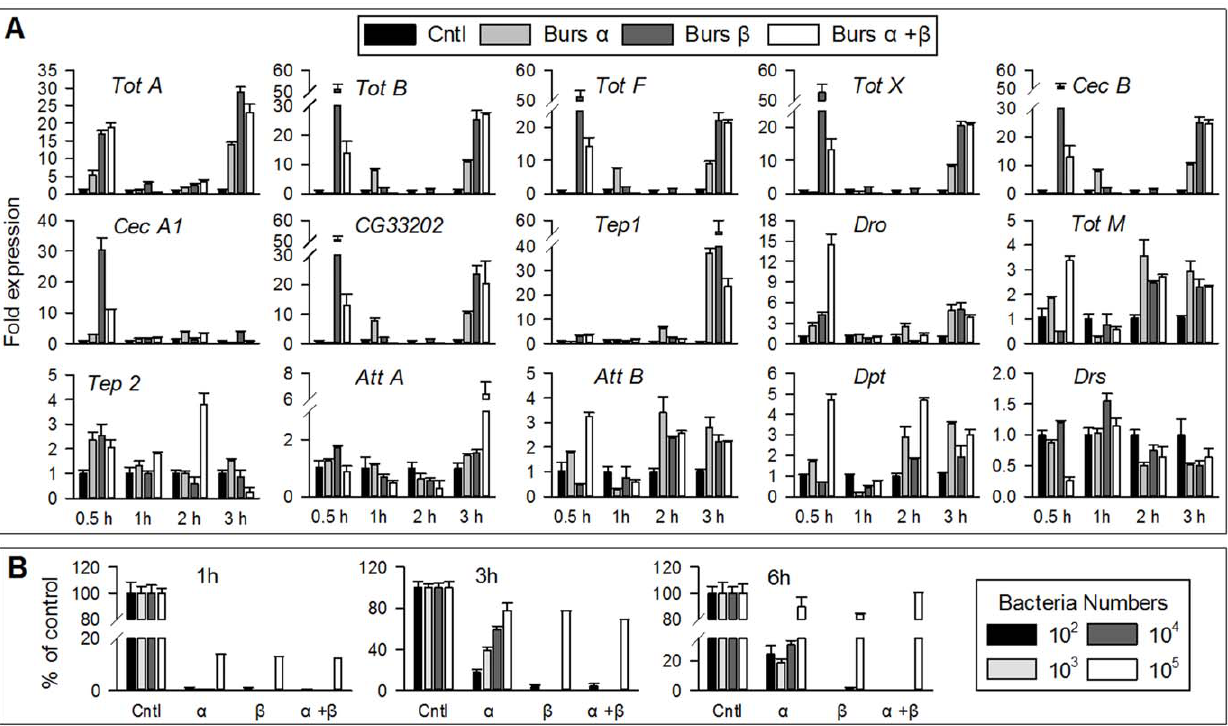
Figure 3. Burs a 2 a and burs b 2 b treatments induced expression of AMP genes and suppression of bacterial growth in adults. Separate groups of adult flies were neck-ligated immediately after emergence and at 1 h post-ligation injected with 60 ng/0.5 m l of r-burs a 2 b , burs a 2 a , or burs b 2 b . The control flies were injected with the purified cell culture transfected with blank pcDNA 3.1 vector. After the indicated incubation periods, expression of the AMP genes was determined by qPCR. (A) AMP transcript levels in wild type adults. For bacterial inhibition assay (B), neck-ligated wild type flies were injected with r-burs a 2 b heterodimer, burs a 2 a homodimer, burs b 2 b homodimer or blank vector transfected sample, respectively, homogenized and centrifuged for 15 min at 16,000 g. The resulting supernatants were challenged with indicated titers of E. coli for 6 h before plating for colony count. The histograms show the means 6 SEM, n=3 biologically independent experiments.